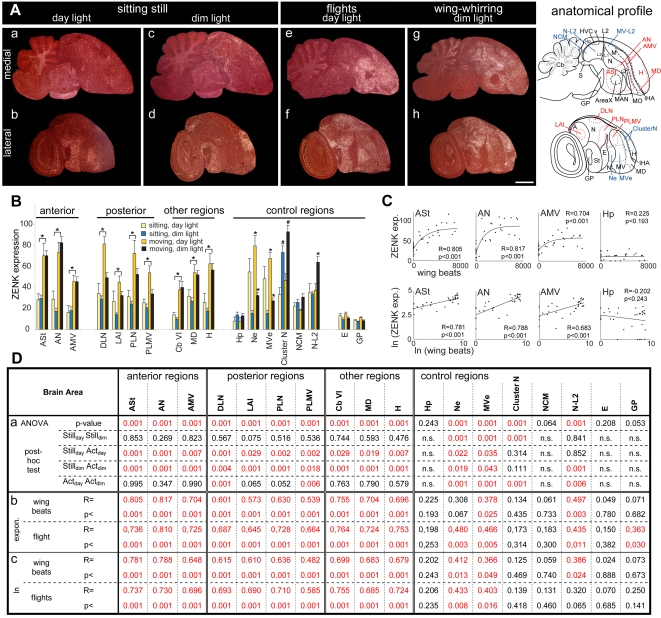
Movement-induced ZENK expression in garden warblers.A. Darkfield images of medial (top) and lateral (bottom row) sagittal sections from birds sitting relatively still in room day light (a, b) or dim night light (c, d) and birds making mostly flights in day light (e, f) or wing whirring in dim light (g, h). The anatomical profiles to the right show the extent of the movement-induced (red) and visual-induced (blue) gene expression areas. Note that the PLN and PLMV areas differ slightly in shape between garden warblers (panel Af,h) and zebra finches (Fig. 2A), due to differences in the shapes of the N and MV cerebral subdivisions and that the warbler sections are more lateral. Anterior is right, dorsal is up. Scale bar, 2 mm. B. Quantification of ZENK expression levels in different brain areas from the four groups of warblers. Anterior and posterior areas were grouped according to their relative location to vocal nuclei. * = p<0.05, one-way ANOVA followed by Holm-Sidak multi-comparison test, comparing moving groups with still groups for each light condition; each movement group showed significant differences with each still group. # = p<0.001 for an increase in Cluster N in dim versus day light groups, whether still or moving. Error bars, S.E.M. C. Correlation between the amount of wing beats and ZENK expression levels shown in exponential (top row) and double natural logarithmic (bottom row) graphs for example areas. Each dot represents the value of one bird. D. Statistical analyses: (a) one-way ANOVA followed by Holm-Sidak all-pairwise multi-comparison test for the brain areas in (B); (b) exponential regression stats (examples in C, top row); (c) linear regression stats on double-logarithmic transformation of the data (C, bottom row). Red text are significant differences (p<0.05); n.s. = not significant.